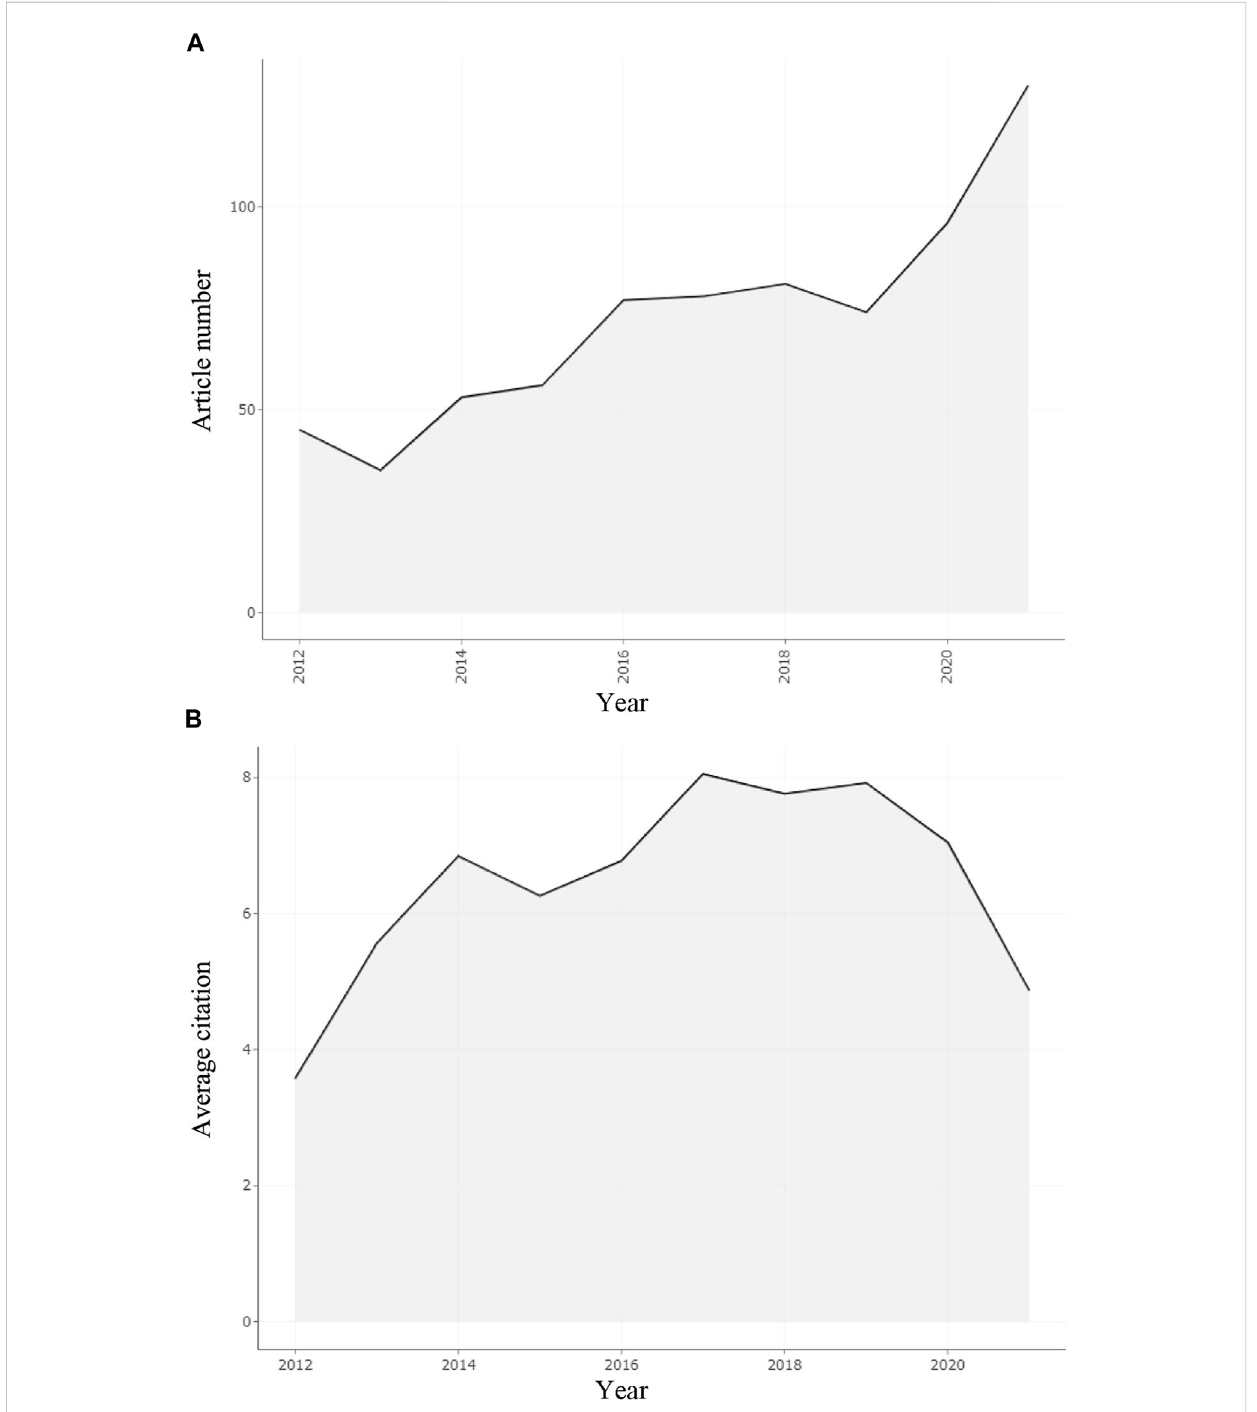
Annual scienti fi c production and average citations per year from 2012 to 2021. (A) Annual scienti fi c production from 2012 to 2021 in the fi eld. (B) Average article citations per year from 2012 to 2021 in the fi